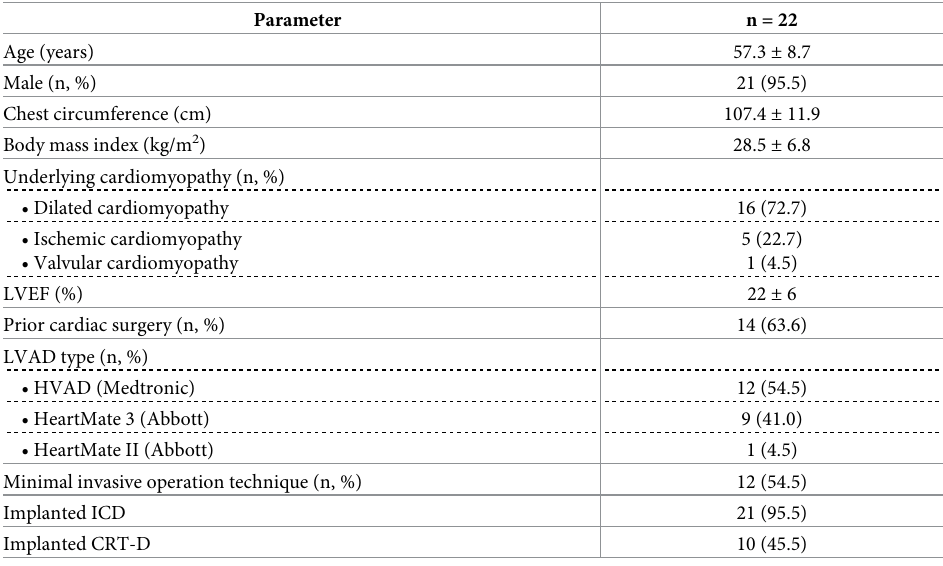
Table 1. Baseline patient characteristics (n =